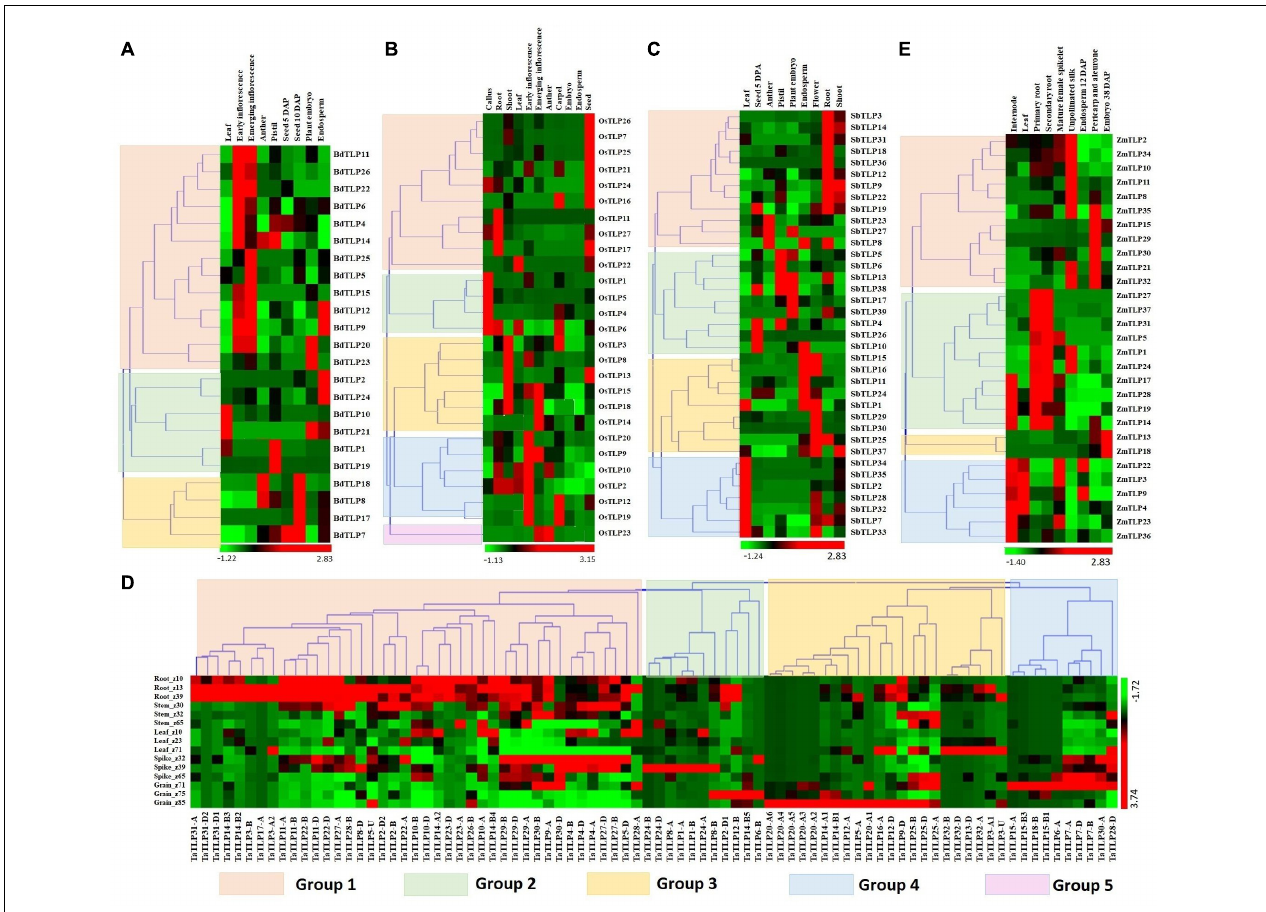
FIGURE 5 | Expression analysis of TLP genes of B. distachyon ( BdTLP ), O. sativa ( OsTLP ). S. bicolor ( SbTLP ), T. aestivum ( TaTLP ), and Z. mays ( ZmTLP ) under various tissue and developmental stages. Heat maps (A–E) show the clustering and expression profiling of TLP genes in (A) B. distachyon , (B) O. sativa , (C) S. bicolor , (D) T. aestivum, and (E) Z. mays . The different clusters are formed based on expression values of TLP genes in the respective crop, which are represented with different colors. The color bar depicts the upregulated and downregulated expression with red and green colors,